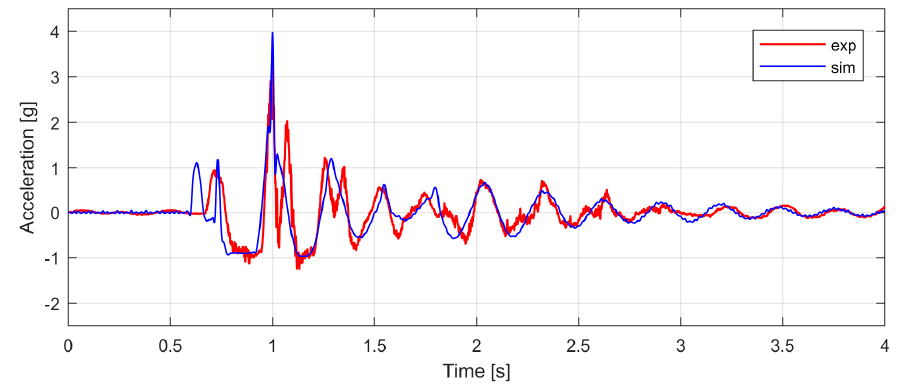
.. z FL av , and numerical results (sim),  FL z , and numerical results (sim), av